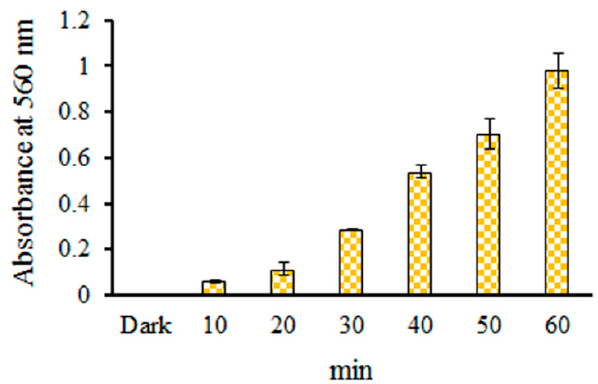
Figure 3. Effects of 1 mM EC on nitro blue tetrazolium (NBT) reduction by blue light irradiation at 2.0 mW/cm 2 for 10–60 min. The results are represented by mean ± standard deviation, where n = 3. Statistically significant differences ( p < 0.05) between each treatment are indicated by the different letters above each bar.